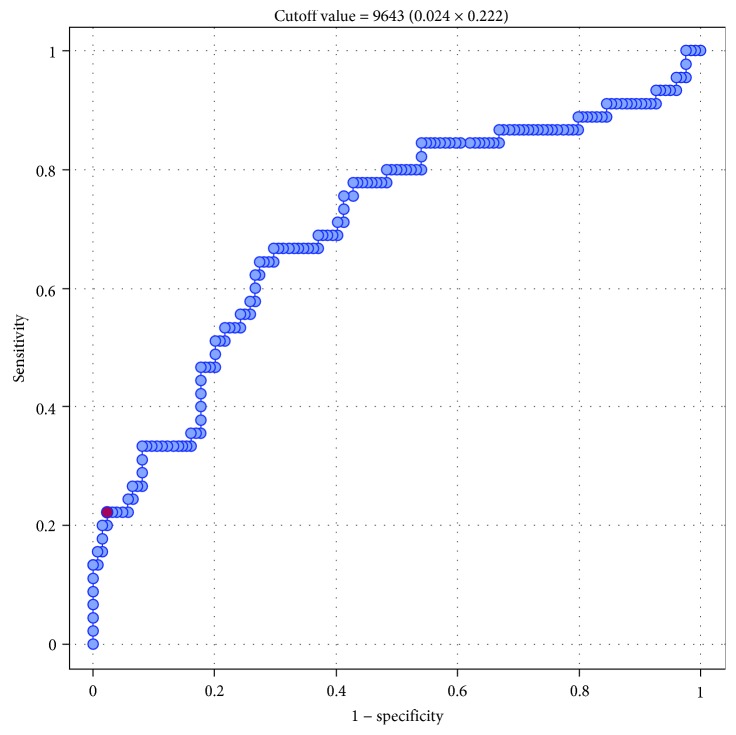
ROC curve—relationship between sFlt-1 concentrations (pg/ml) and occurrence of gestational hypertension (AUC 70.1%).